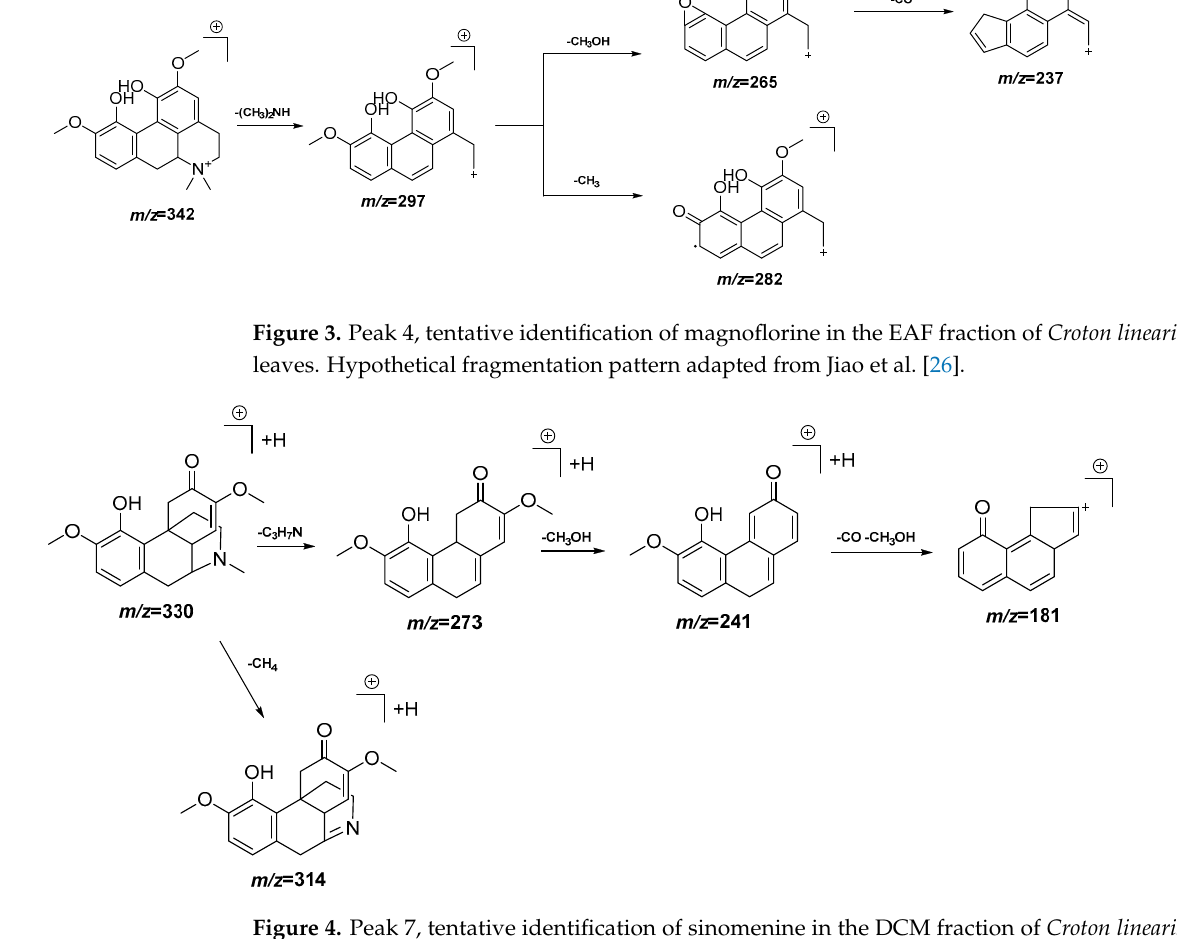
Figure 4 . Peak 7, tentative identification of sinomenine in the DCM fraction of Croton linearis Jacq. leaves. Hypothetical fragmentation pattern adapted from Jiang et al. [27].